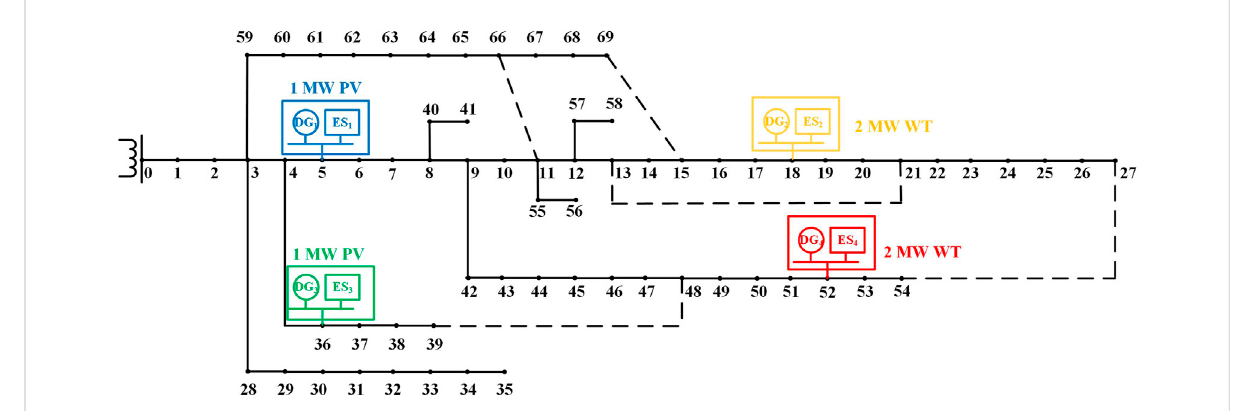
FIGURE 2 The DN topology of the PG&E 69-bus